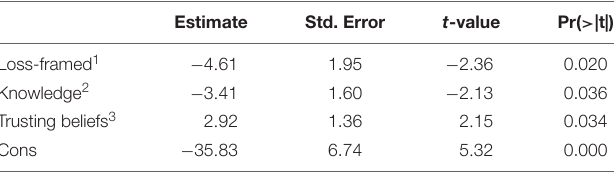
TABLE 2 | Estimated coefficients of the final model for the probability of suffering a cyberattack.